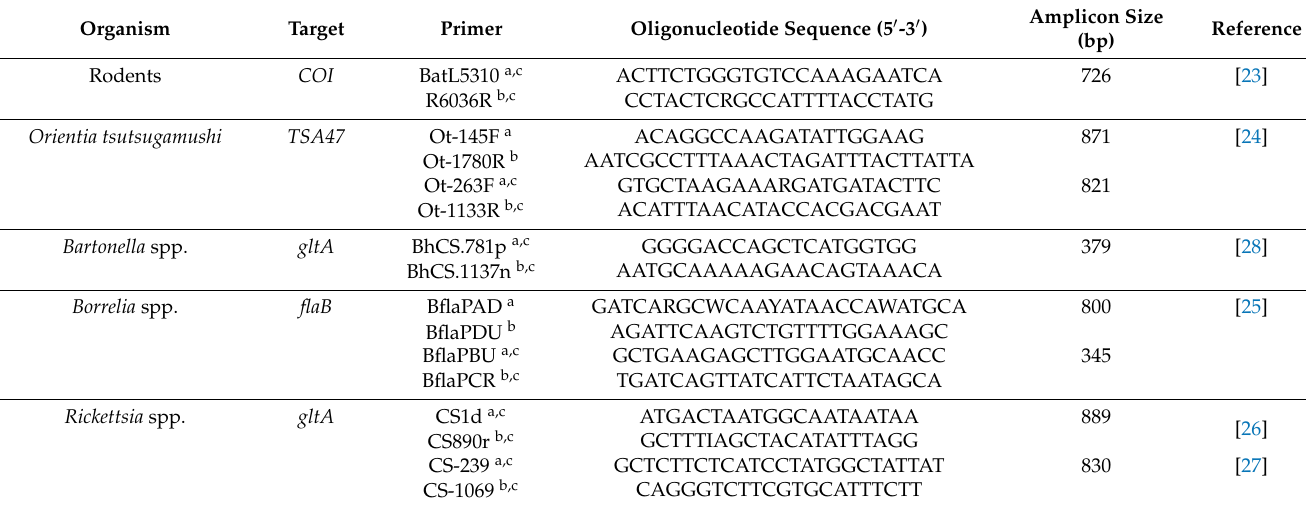
Table 1. Primers used for DNA barcoding and pathogen